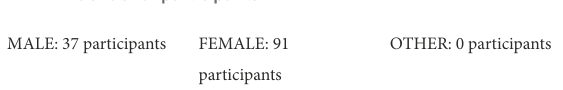
Participants self-identified their